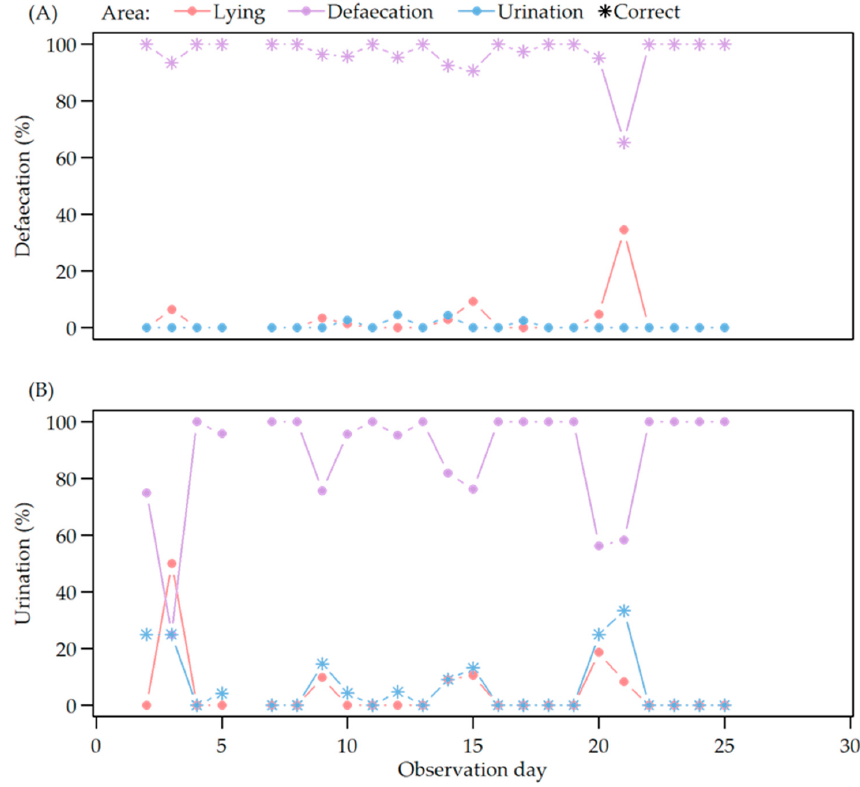
Figure 5. ( A ) Defaecation in relation to observation day during video observation; ( B ) urination in relation to observation day during video observation in the different areas of the pen (lying area, defaecation area and urination area of the toilet).